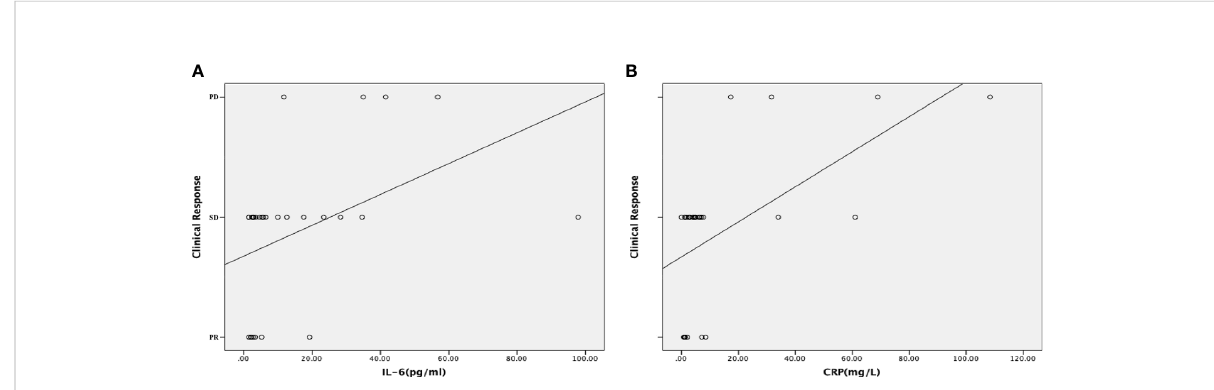
FIGURE 3 Correlations between the dynamic changes in in fl ammatory markers and the clinical response. (A) Correlation between the dynamic changes in the serum interleukin (IL)-6 level and the clinical response. The dynamic increases in the levels of IL-6 positively correlated with progressive disease (PD) during chemotherapy. (B) Correlation between the dynamic changes in the serum C-reactive protein (CRP) level and the clinical response. The dynamic increases in the levels of CRP positively correlated with progressive disease (PD) during chemotherapy. A scatter plot and a fi tted curved were used to show the correlation more intuitively.